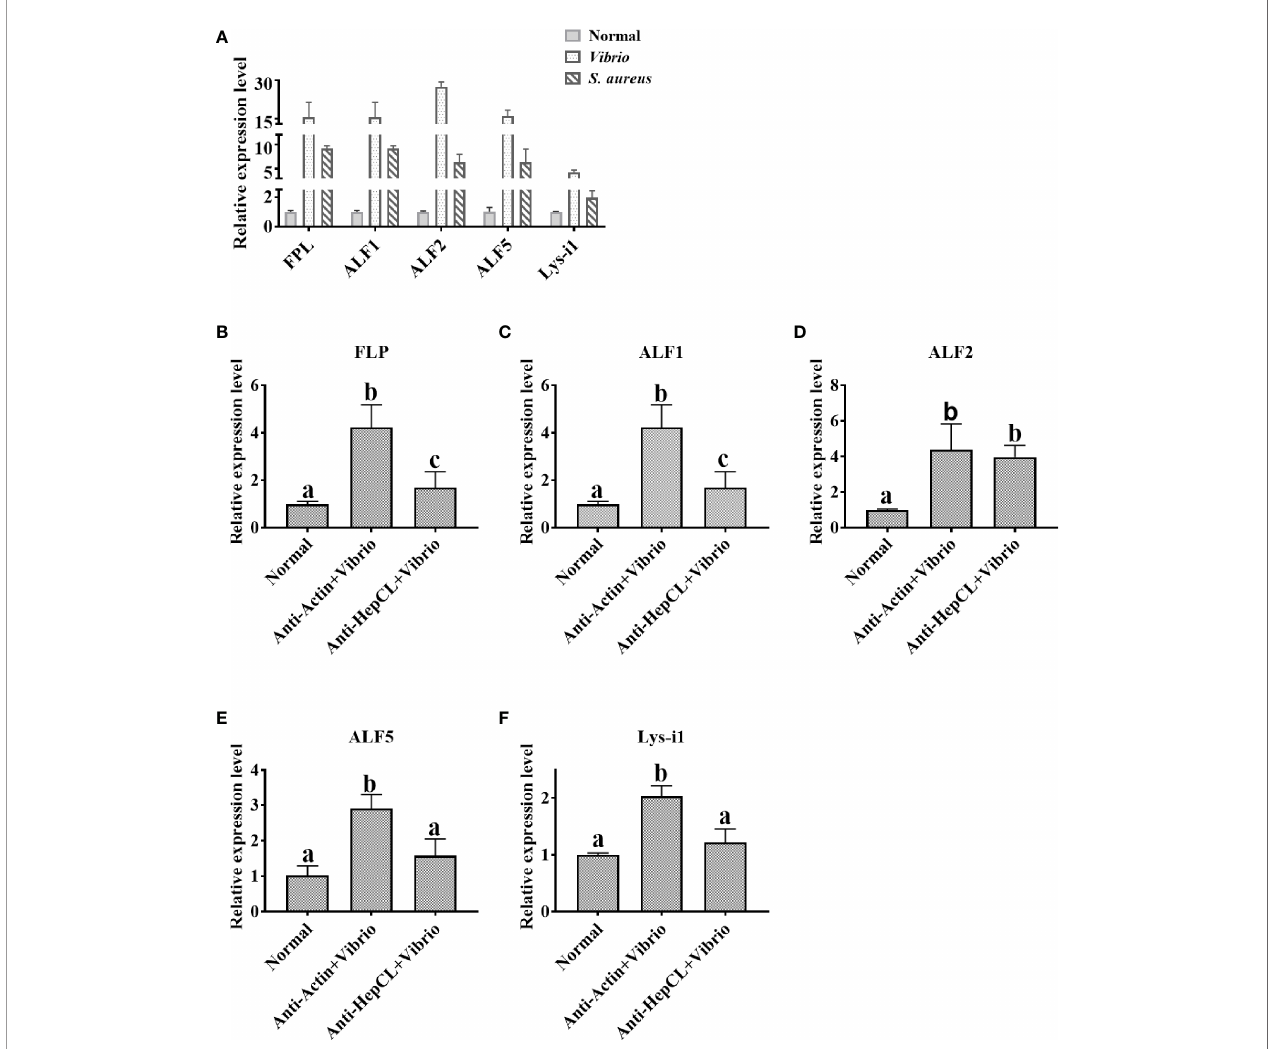
FIGURE 6 | The expression levels of antimicrobial proteins after Anti-HepCL- Vibrio injection. (A) The expression levels of FLP, ALF1, ALF2, ALF5 and Lys-i1 were analyzed by qRT-PCR after Vibrio and S. aureus infection. (B – F) The expression levels of FLP, ALF1, ALF2, ALF5 and Lys-i1 was analyzed when blocked HepCL with Anti-HepCL after Vibrio infection, Anti-actin was used as control. Differences between groups were analyzed using one-way analysis of variance (ANOVA). Different letters indicate signi fi cant differences p <